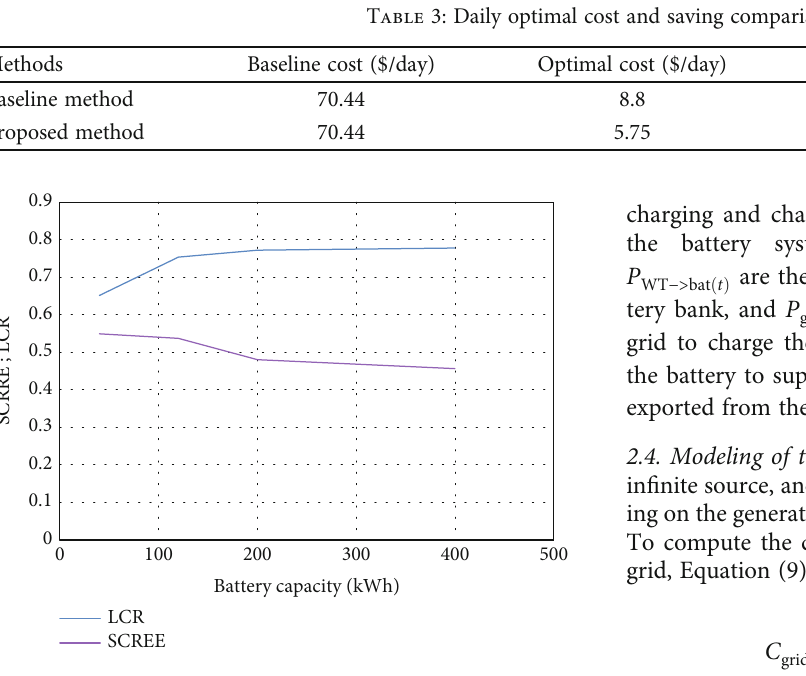
Figure 13: Impact of battery capacity on the SCREE and LCR. Table 4: Technical indicator